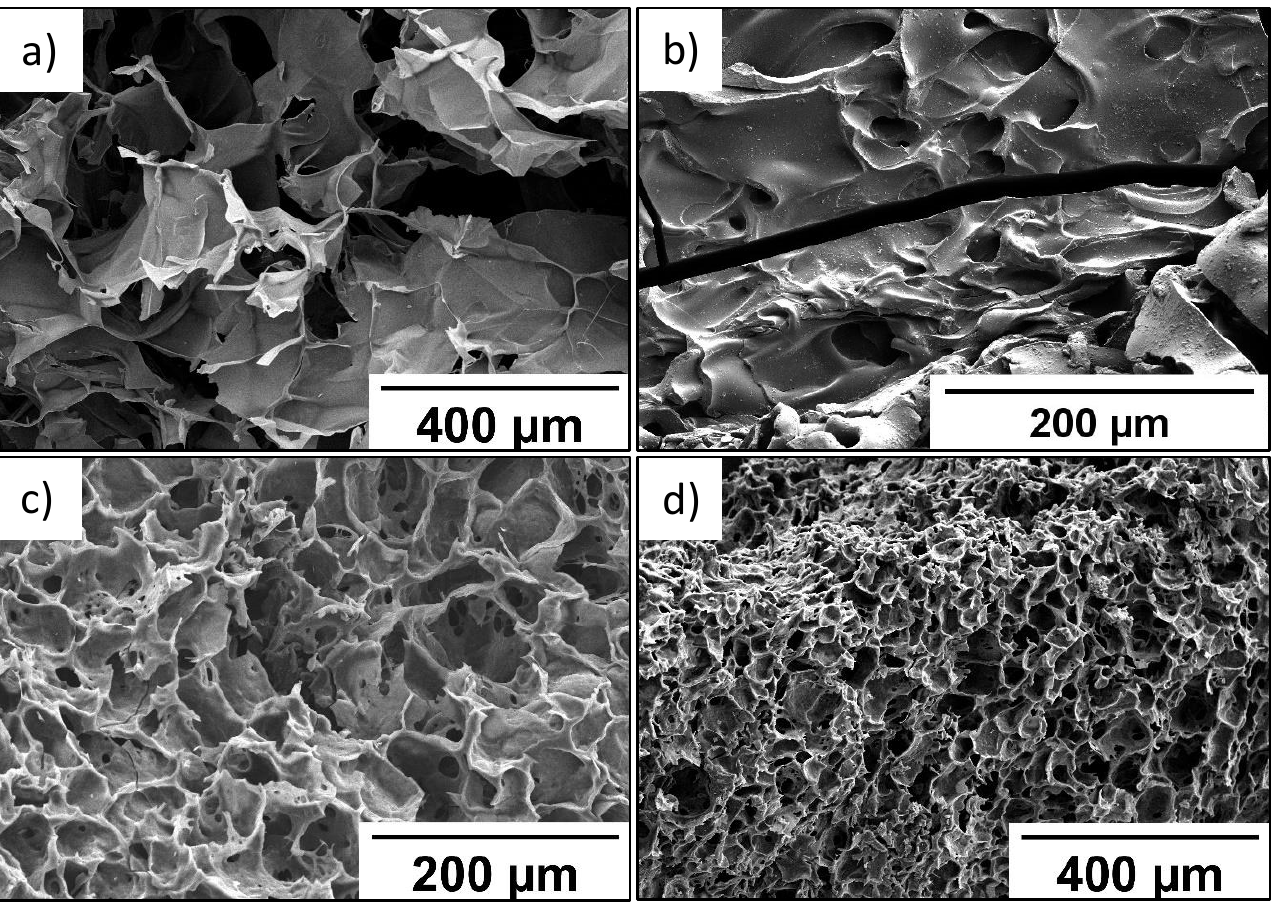
Figure 5. SEM images of films based on P(SBMA-HEMA)@PEDOT ( a , b ) and P(SBMA-VA)@PEDOT ( c , d ).